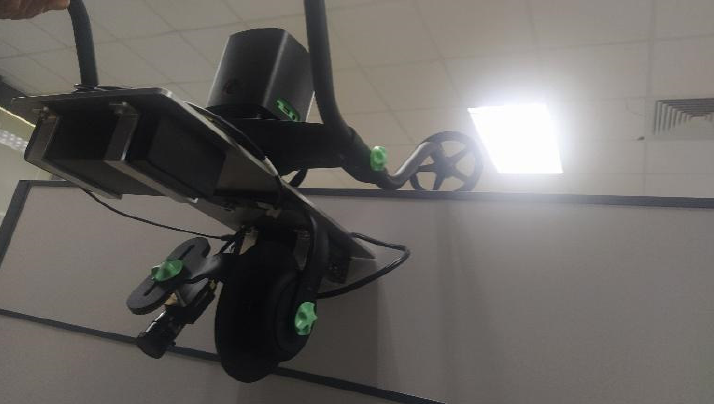
Figure 25. Experimental equipment: load system.